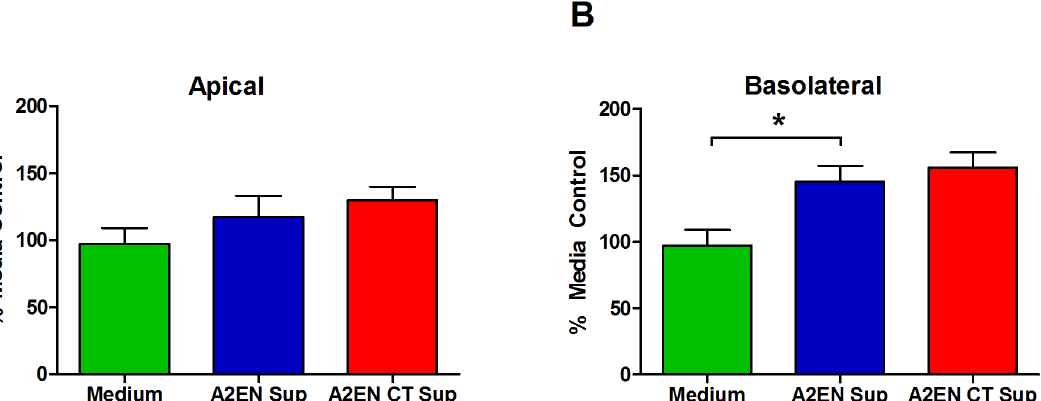
Fig 5. A2EN supernatants do not decrease cell-free HIV viability. A2EN cells were infected with CT serovar D, and supernatants were collected 72 h post-infection. Medium alone, ( A ) apical, or ( B ) basolateral supernatants were incubated with 1000 TCID 50 of cell-free HIV BaL for 3 h. The infectious activity of the virus was then measured by transferring to TZM-bl cells and measuring luciferase activity 48 h later. Data shown is expressed as a percentage of the mean RLU recorded for medium alone controls. Bars represent the mean percentages ± SD. Data is representative of 3 independent experiments, each performed in quadruplicate. * p <